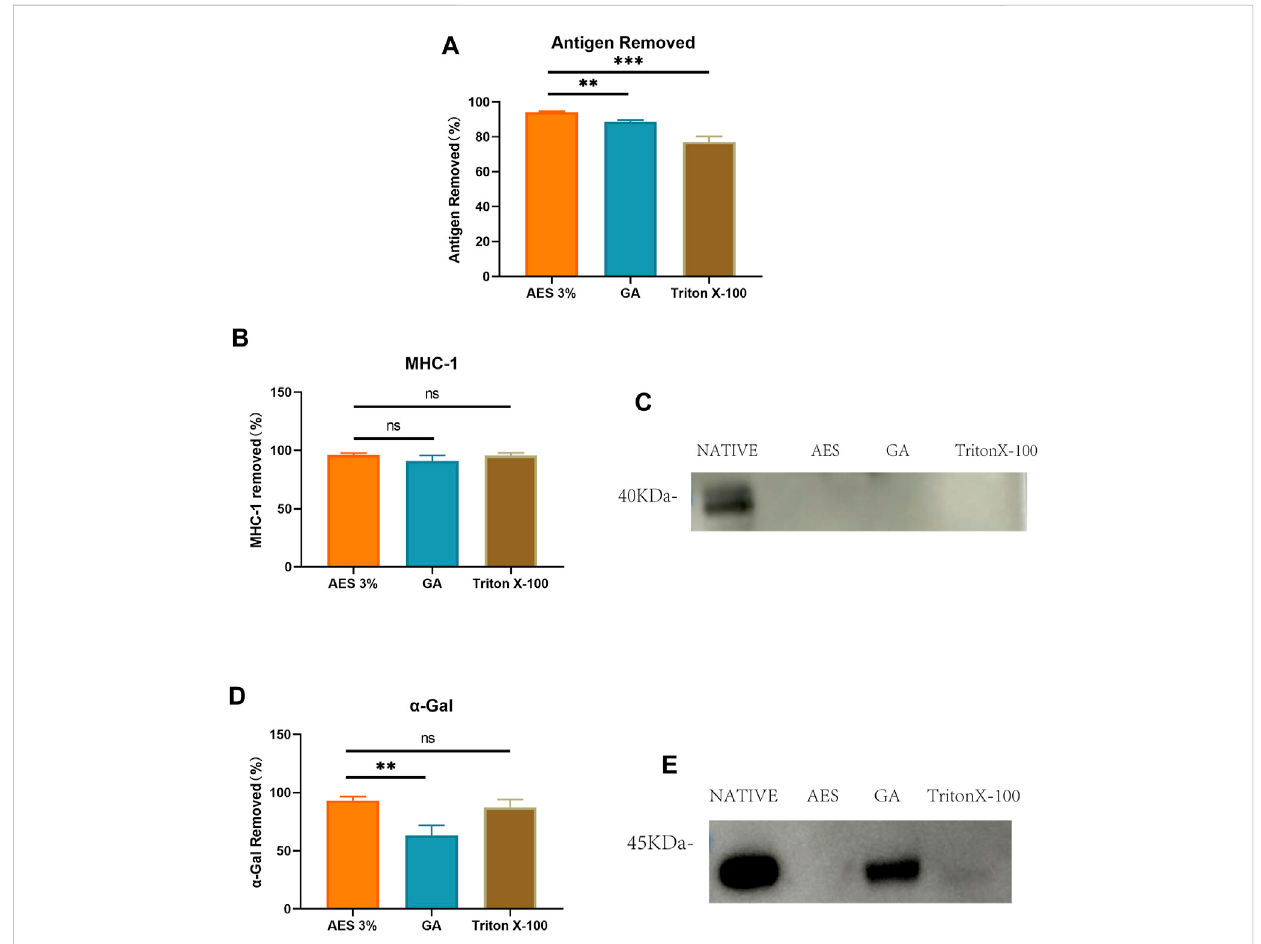
FIGURE 3 (A) UseElisatodetectantigenremovedbyAES,GAandTritonX-100.(P.S.GAactuallydoesnotremoveantigens,butrathersealsthem).Quantitative comparativeanalysis oftransplantation-associated antigensincludingMHC-1 (B) and α -Gal (D) ; (C) and (E) show thattheexpression ofMHC-1and α -Gal on Western-Blot (n = 3; * p < 0.05; ** p < 0.01; *** p < 0.001; ns represents no signi fi cant